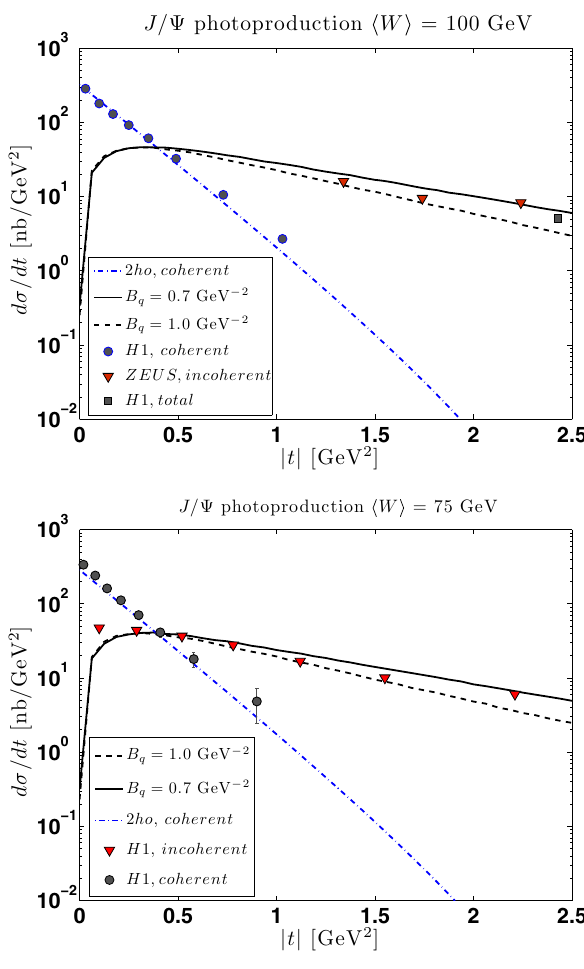
Fig. 9 Coherent and Incoherent photoproduction ( Q 2 = 0) cross sec- tions within the kinematical conditions of the HERA experiments: upper panel: x IP ≈ 9 . 6 × 10 − 4 for (cid:4) W (cid:5) = 100 GeV; lower panel: x IP ≈ 1 . 7 × 10 − 3 for (cid:4) W (cid:5) = 75 GeV. The dot-dashed lines repre- sent the QMBA-2ho predictions for coherent scattering and the related N NLO gluons. Incoherent scattering calculations within QMBA-2ho are represented by the full lines and dashed lines according to the fluc- tuation parameter B q (see legend). Data as in Fig. 4